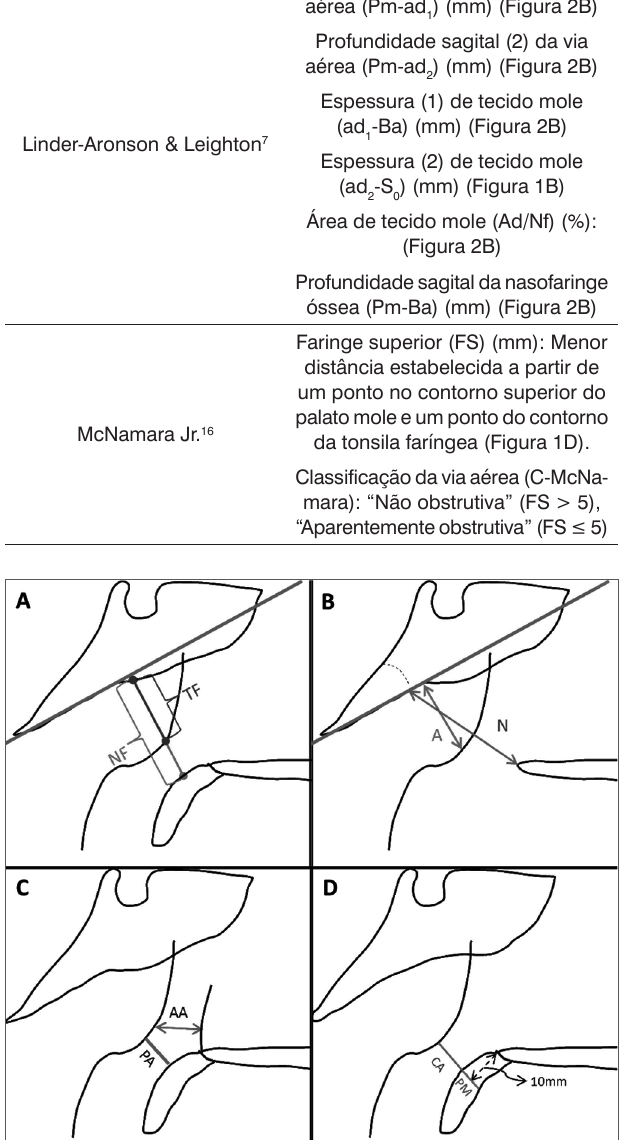
Figura 1. Ilustrações dos parâmetros de RC. (A): TF: Tonsila faríngea; NF: nasofaringe. (B): A: adenoide; N: nasofaringe. (C): AA: antroadenoide; PA: passagem aérea. (D): CA: coluna aérea; PM: palato